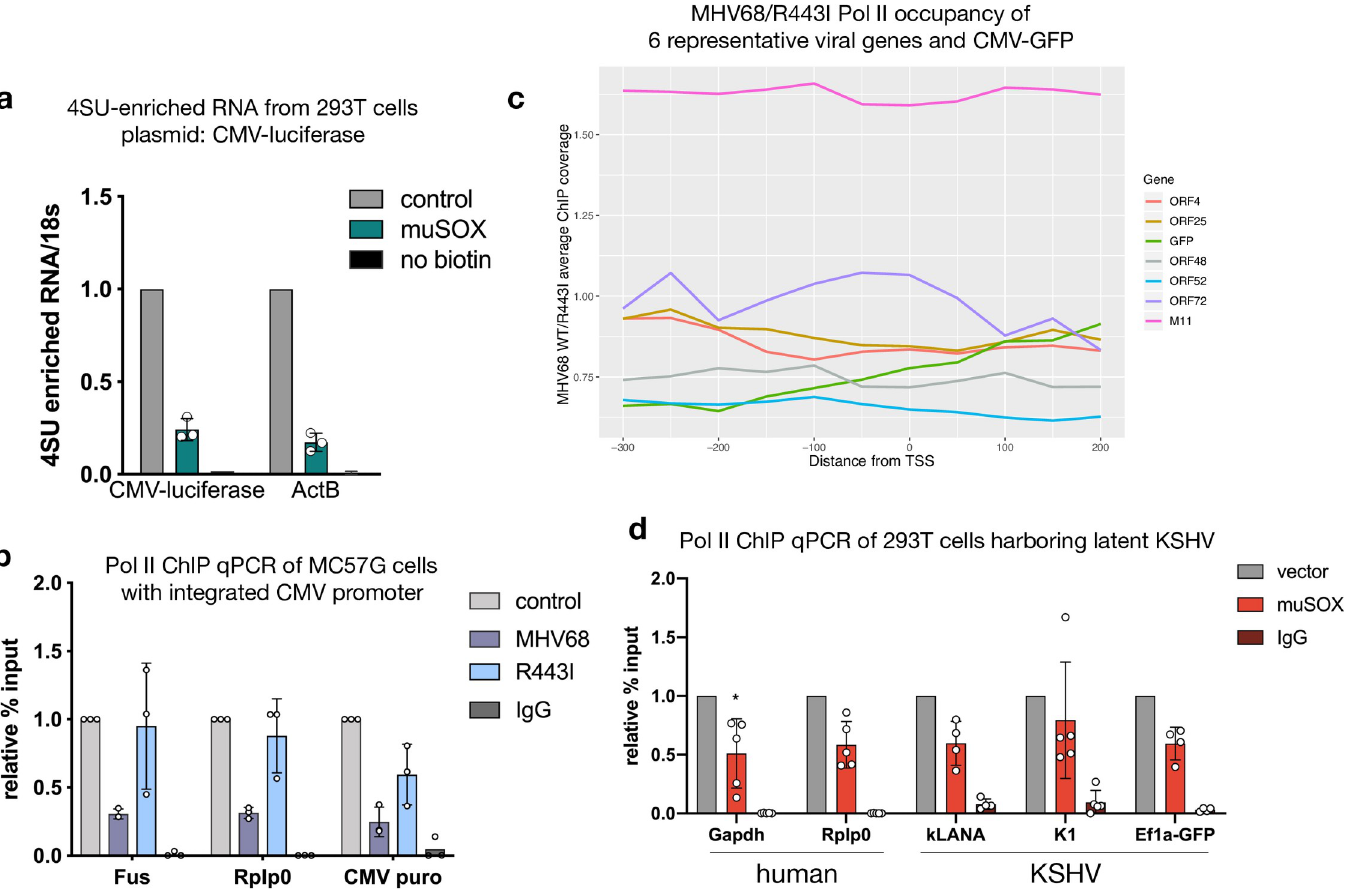
Fig 7. A non-MHV68 promoter escapes repression on the viral genome. (A) 293T cells were transfected with muSOX or a GFP control fused to the cell surface glycoprotein Thy1.1 with an intervening P2A ribosome skipping sequence. Pure populations of transfected cells were obtained by running cells over columns that enrich for Thy1.1 [23], whereupon 500 μ M of 4SU was added for 10 min and labeled RNA was isolated by biotin-streptavidin pull down. Levels of newly transcribed RNA from the indicated genes were measured by RT-qPCR. All samples were normalized to 18S and levels of RNA from control GFP expressing cells were set to 1. (B) The CMV promoter driving puromycin resistance was lentivirally integrated into MC57G cells. The cells were then infected with WT MHV68 or R443I at an MOI of 5 and Pol II levels at the indicated promoters were assayed by Pol II ChIP-qPCR. (C) ChIP-seq traces comparing WT MHV68 to R443I coverage from -300 to +200 around the TSS in 25 bp bins, averaged from two biological replicates of infected MC57G cells. Six representative viral genes and CMV-GFP are shown. (D) 293T cells were infected with KSHV and then transfected with muSOX twice over a 24 h period to induce accelerated RNA turnover. Pol II levels at the indicated KSHV and human promoters were measured by ChIP-qPCR and plotted with standard deviation. ( � p < 0.05, students t-test on raw % input